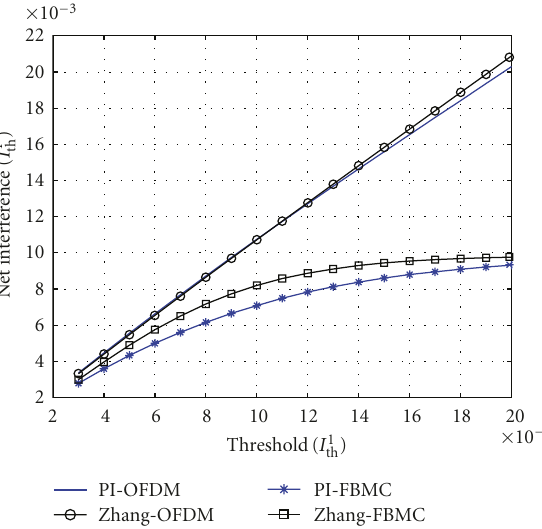
Figure 10: Achieved CR versus allowed interference threshold (low) for OFDM- and FBMC-based CR systems—two active